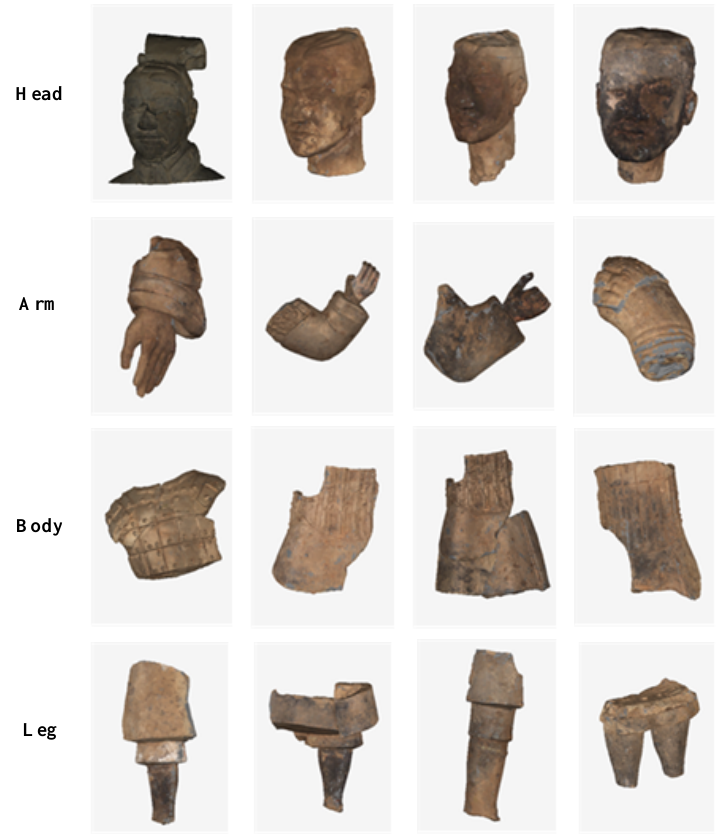
Figure 7. Several fragments displayed by category.